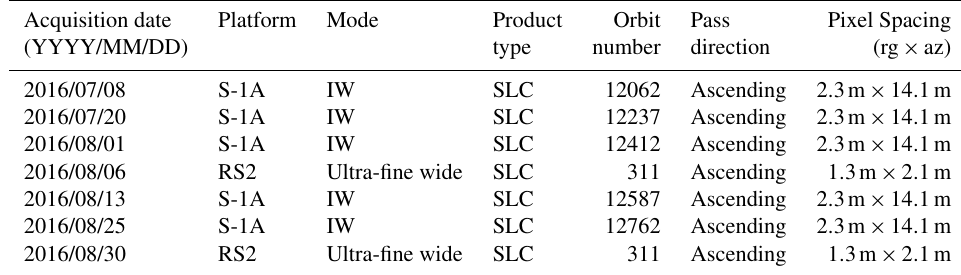
Table 1. Sentinel-1A and RADARSAT-2 acquisitions of Eqip Sermia investigated in this study. Acquisition date